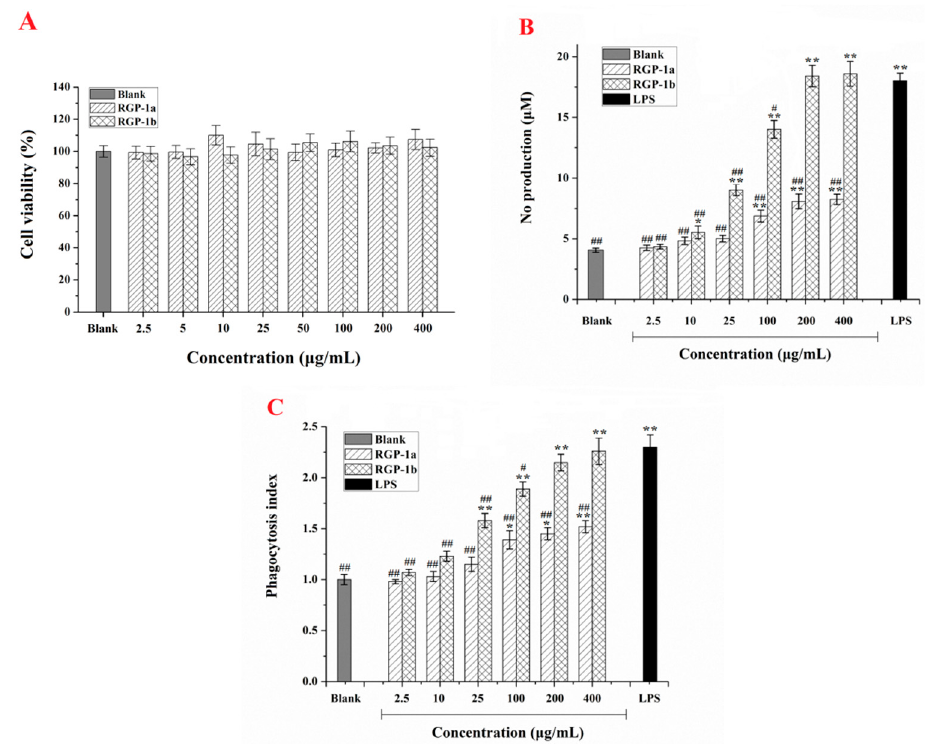
Figure 4. Effects of RGP-1a and RGP-1b on proliferation ( A ); NO production ( B ); and phagocytosis index ( C ) of RAW 264.7 cells. Cells were treated with RGP-1a and RGP-1b at various concentrations for 24 h. The values are presented as mean ± S.D. ( n = 5). * p < 0.05, ** p < 0.01 compared with blank group; # p < 0.05, ## p < 0.01 compared with LPS (2 µ g/mL) group.